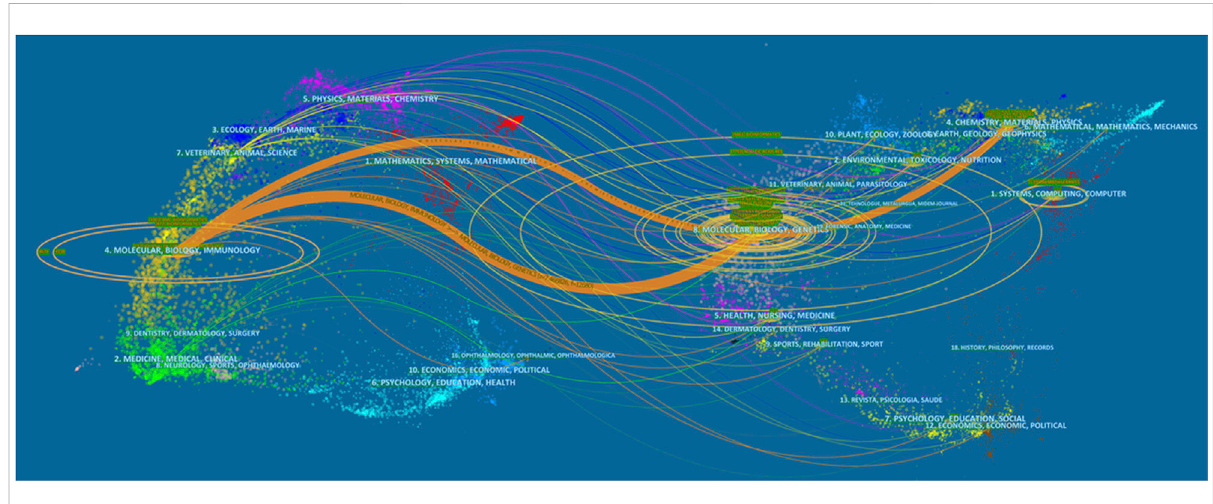
FIGURE 6 The dual-map overlay of journals contributed to publications.